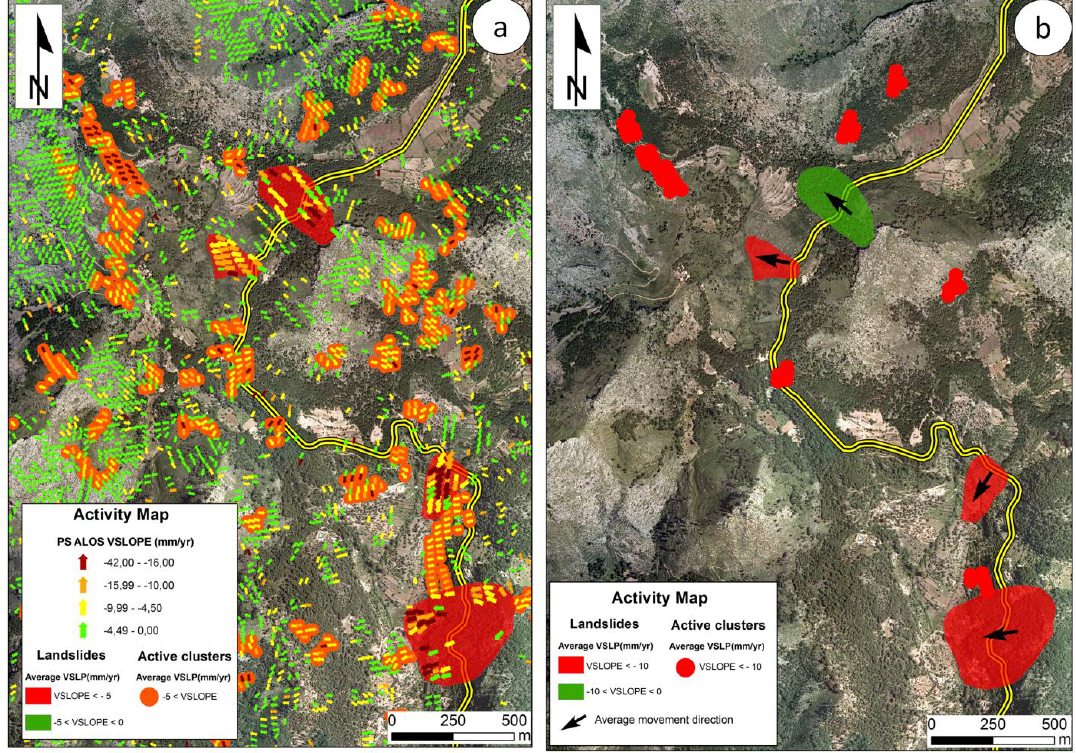
Figure 9. Landslide activity maps: ( a ) Average V landslide map with −10 mm/yr threshold according to